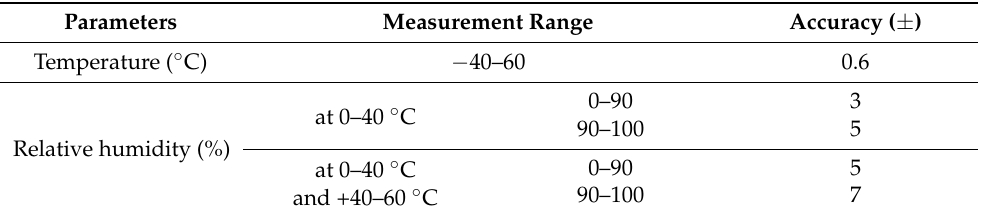
Table 2. HPM 60 temperature and relative humidity sensors